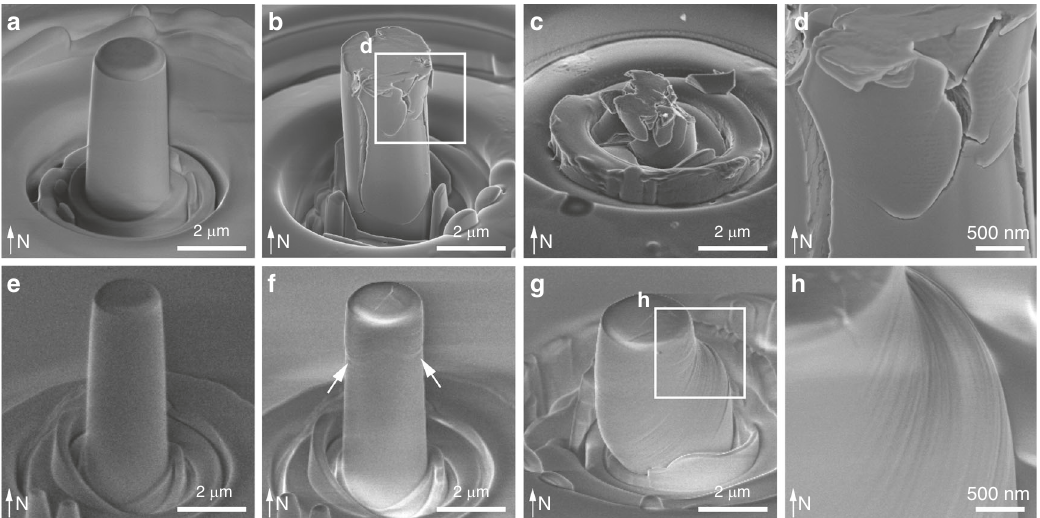
Fig. 4 Deformation of biogenic and geological calcite via uniaxial micro-pillar compression tests. SEM images of a – d biogenic and e – h geological calcite under sequential deformation steps, including the calcite a , e before compression, b , f immediately after yielding, and c after complete fracturing or g signi fi cant plastic deformation. White arrows in f show the initial slip-induced deformation in geological calcite. d , h High-magni fi cation SEM images show d microcracking in the A. rigida biogenic calcite, and h slips in the geological calcite,